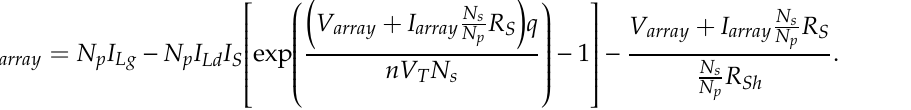
Table 1. The disclaimers of the Solarex (MSX60) photovoltaic module [26]. PV Panel